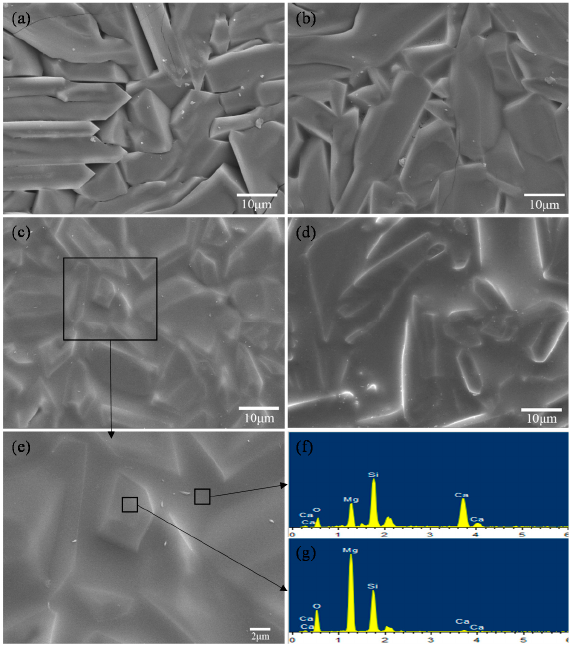
Figure 3. Morphologies of the scaffolds with different CaSiO 3 content: ( a ) 0 wt %; ( b ) 10 wt %; ( c , e ) 20 wt %; ( d ) 25 wt % and ( f , g ) energy dispersive spectroscopy spectrums of the scaffold with 20 wt % CaSiO 3 .